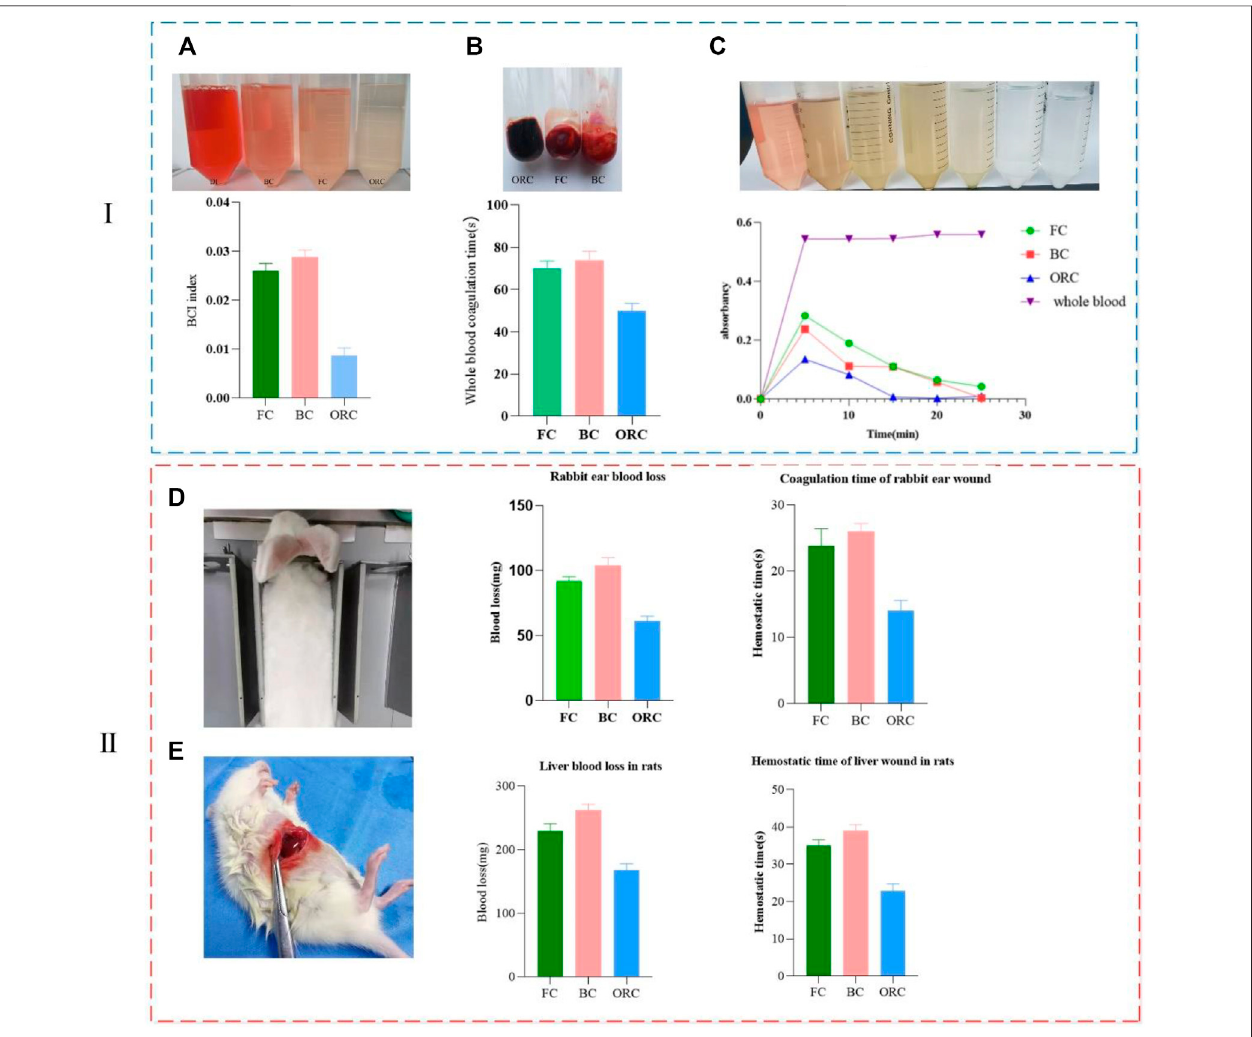
FIGURE 5 | Comparison of clotting ability regarding the three materials in vitro (i) and vivo (ii) (collagen sponge-FC, bovine collagen sponge-BC, oxidized regenerated cellulose-ORC). (A) Comparisons regarding blood clotting index (BCI). (B) Whole blood coagulation time. (C) Dynamic coagulation curve. (D) Coagulation time and blood loss in rabbit ear wound. (E) Coagulation time and blood loss in liver wound of rats.